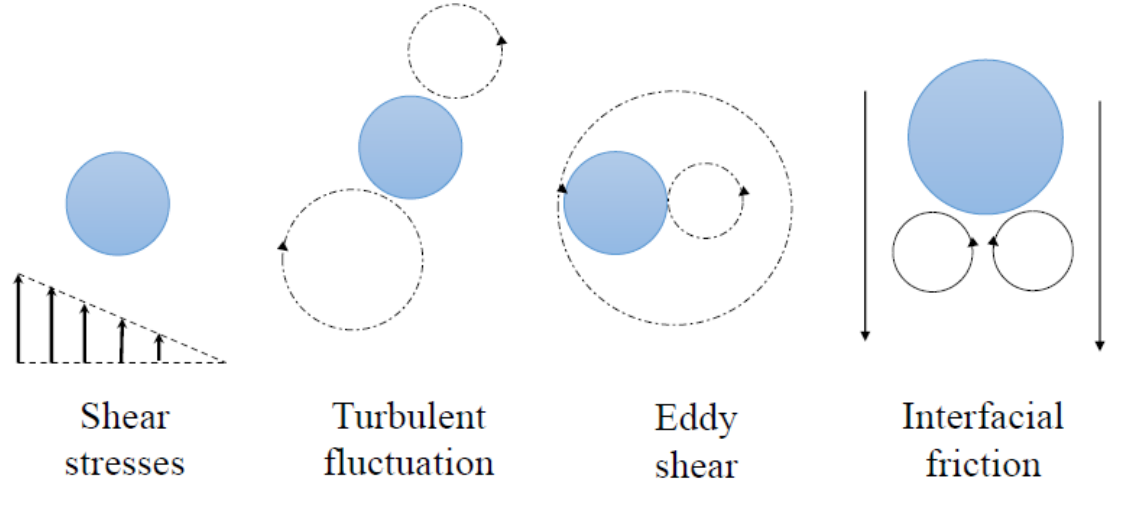
Figure 11. Breakup